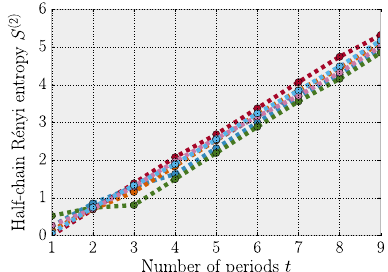
FIG. 8. Time evolution of the second R´enyi entropy between two halves of a 40-site chain in the periodic Clifford circuit defined in Eq. (33). The plot shows the growth of entanglement for seven different initial random product states. After the first few steps, the growth rate of entanglement becomes roughly the same for all initial states, set by the fact that the majority of operators travel with a fixed velocity of 1 site per 1